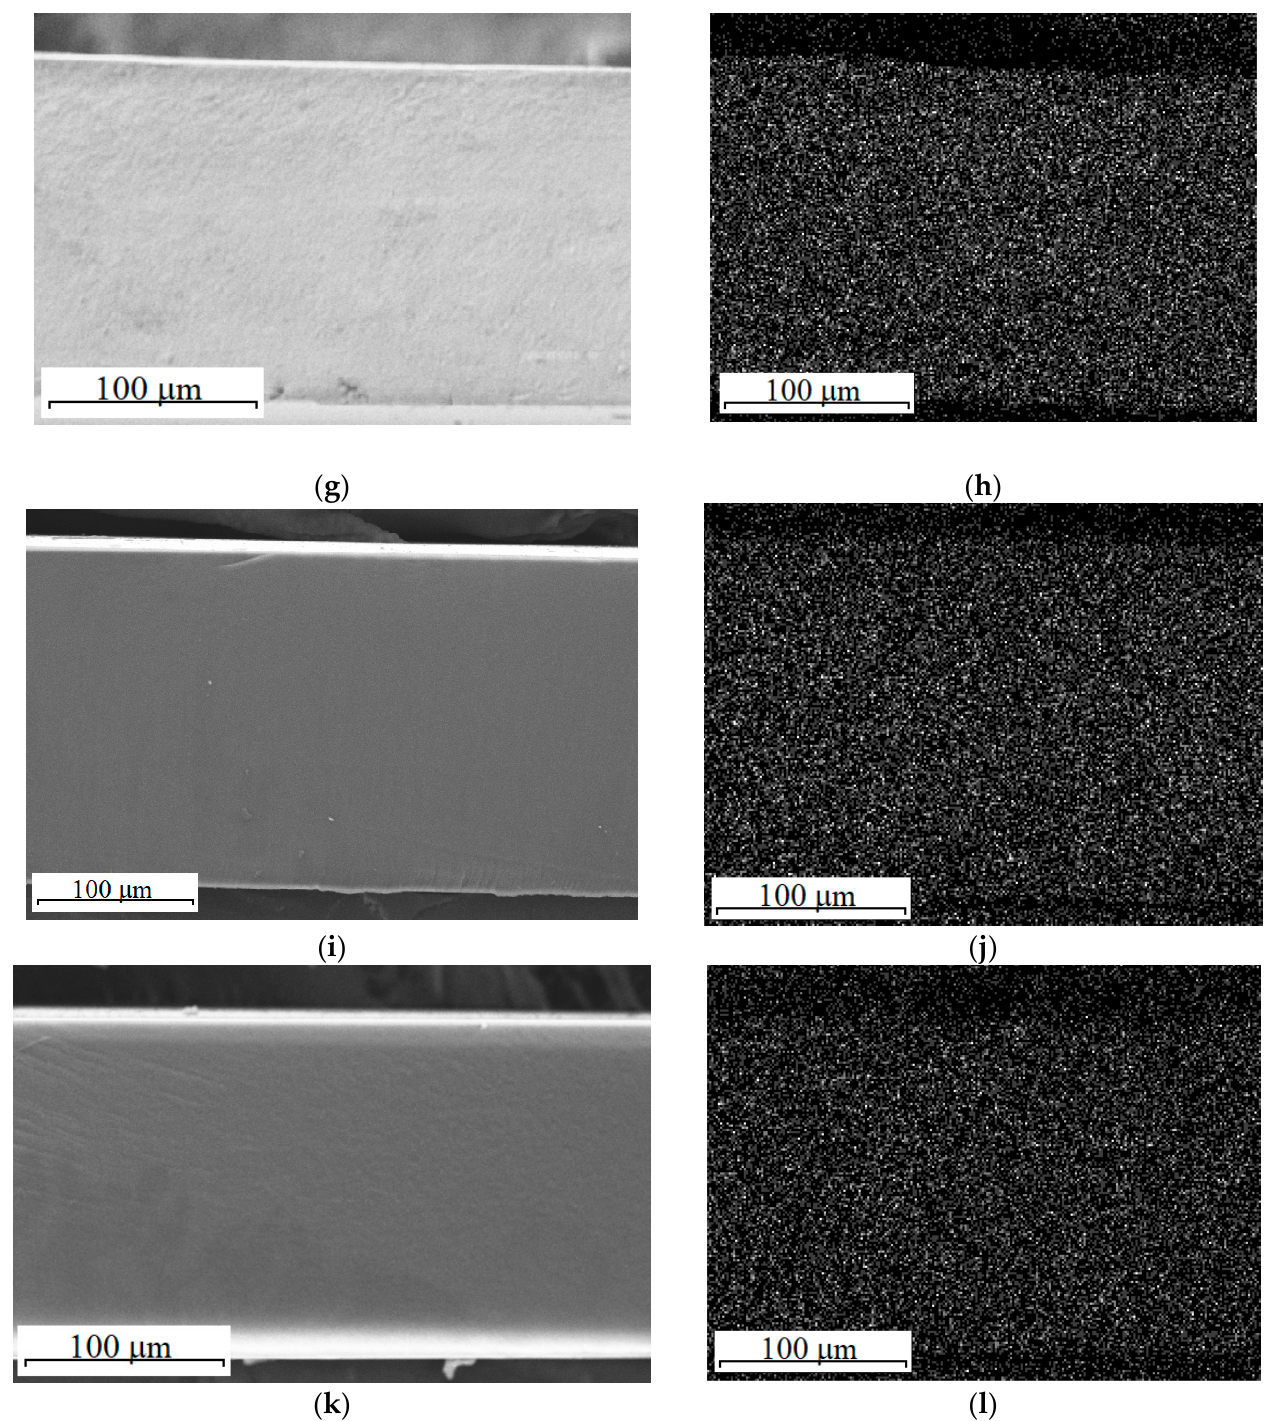
Figure 2. The cross ‐ section SEM images ( a , c , e , g , i , k ) and EDS cerium mappings ( b , d , f , h , j , l ) of the NC3 ( a , b ), NC3_1HP ( c , d ), NC3_1HS ( e , f ), NC4 ( g , h ), NC4(S) ( i , j ), and NC4(NS) ( k , l ) composite membranes.